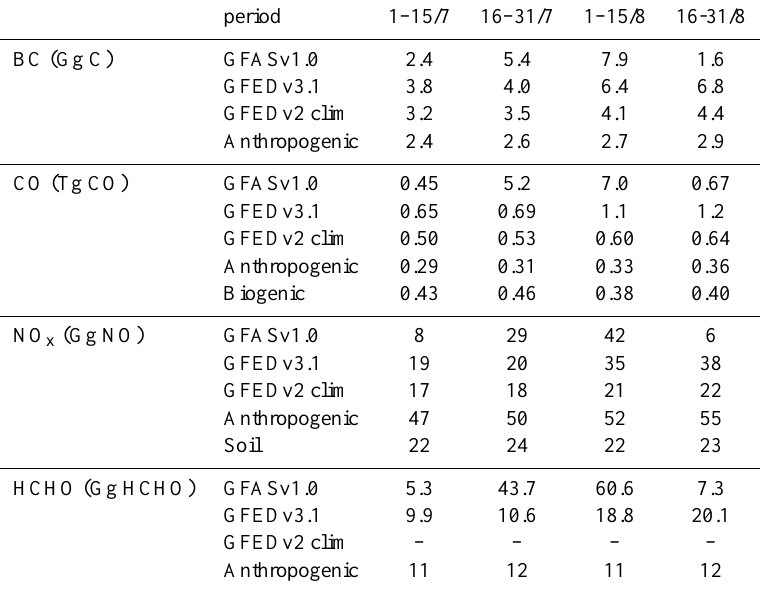
Table 3. Emission totals over western Russia for daily GFASv1.0, GFEDv3.1 monthly emissions, the GFEDv2 climatological emissions, as well as anthropogenic and biogenic emissions as used in the hindcast runs. Anthropogenic emissions are from RETRO (Schultz et al., 2007) and biogenic emissions from GEIA (Guenter et al., 2005) for CO and from ORCHIDEE (Lati`ere et al., 2006) for NOx and HCHO.